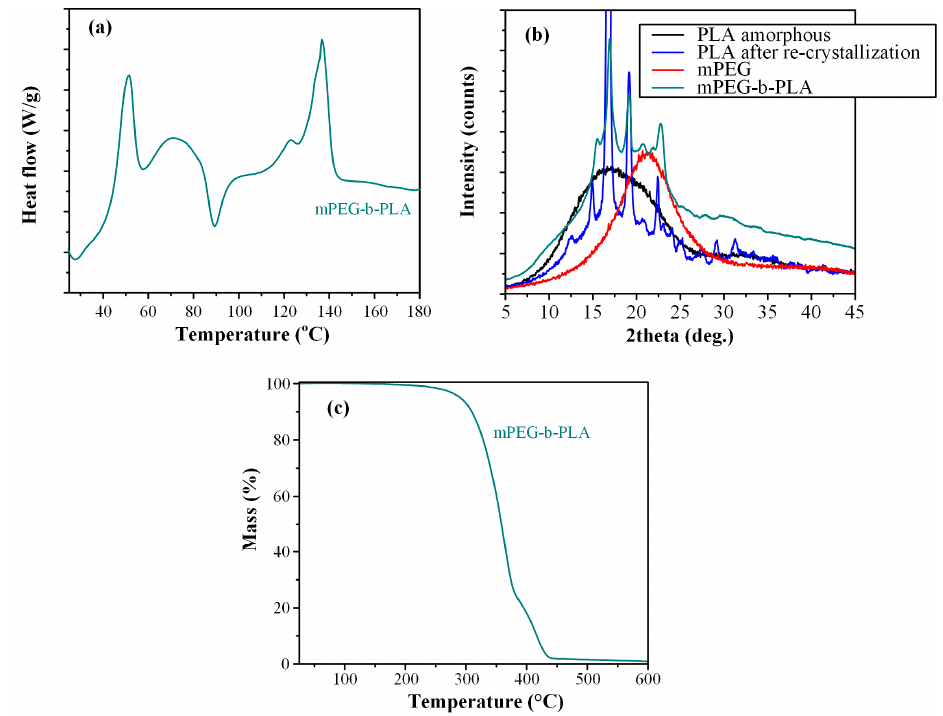
Figure 8. DSC thermogram ( a ), pXRD diffractograms ( b ), and TGA thermogram ( c ) of mPEG-b- PLA.